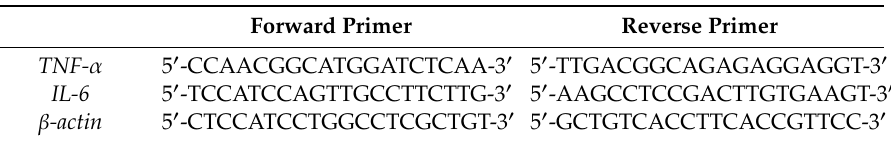
Table 1. The sequences of the